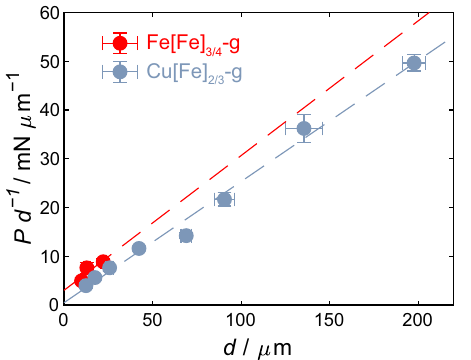
Fig. 6 Mechanical properties of glass. Bernhardt plot of the Vickers indentation data for the Fe[Fe]3/4-g (red) and Cu[Fe]2/3-g (blue) monolith samples. The linear fi t is used to extract the constants in Eq. 3 (see Methods) and, from the slope, ultimately to provide the Vickers hardness at in fi nite load as presented in Supplementary Table 8. Error bars are expressed as the arithmetic mean ± standard deviations. Source data are provided as a Source Data fi